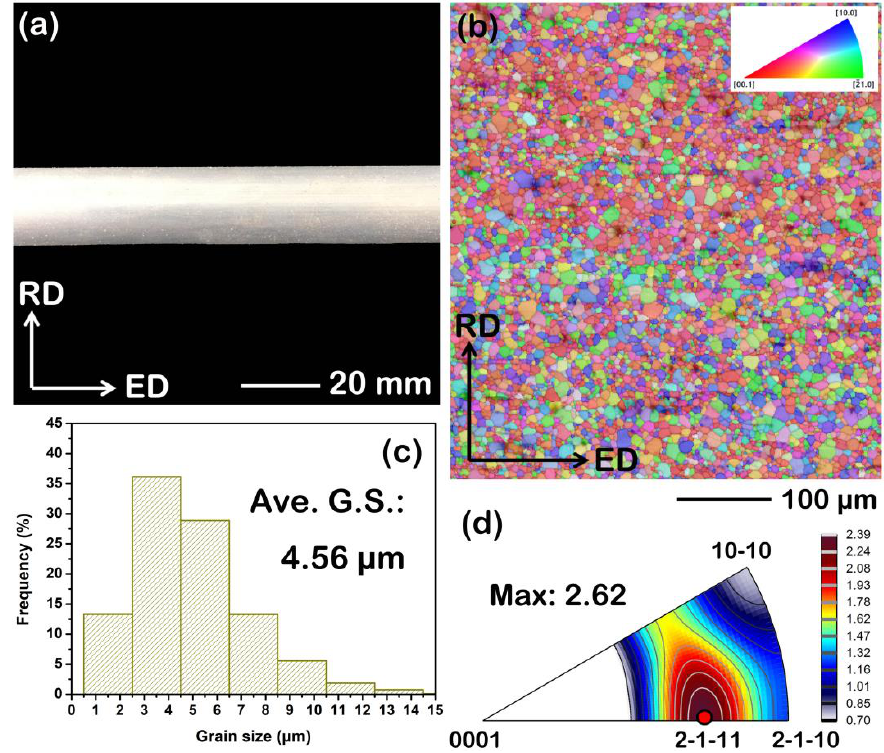
Figure 13. Microstructure analysis of the as-extruded BX31 alloy from longitudinal section (ED-RD plane, RD represents radial direction): ( a ) macroscopic morphology; ( b ) EBSD map; ( c ) grain size distribution map; ( d ) inverse pole figure.